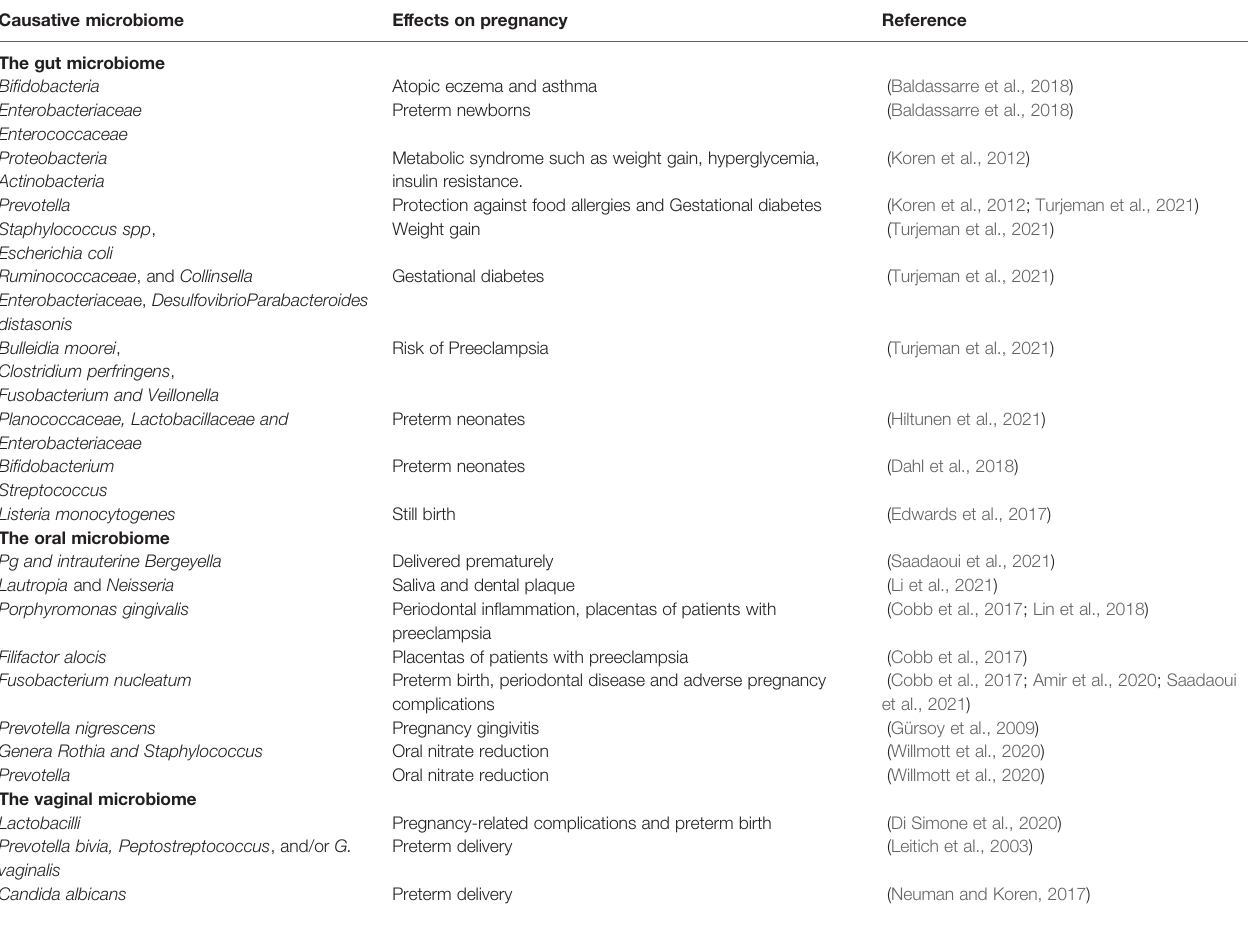
TABLE 2 | List of organisms and their associated effects during